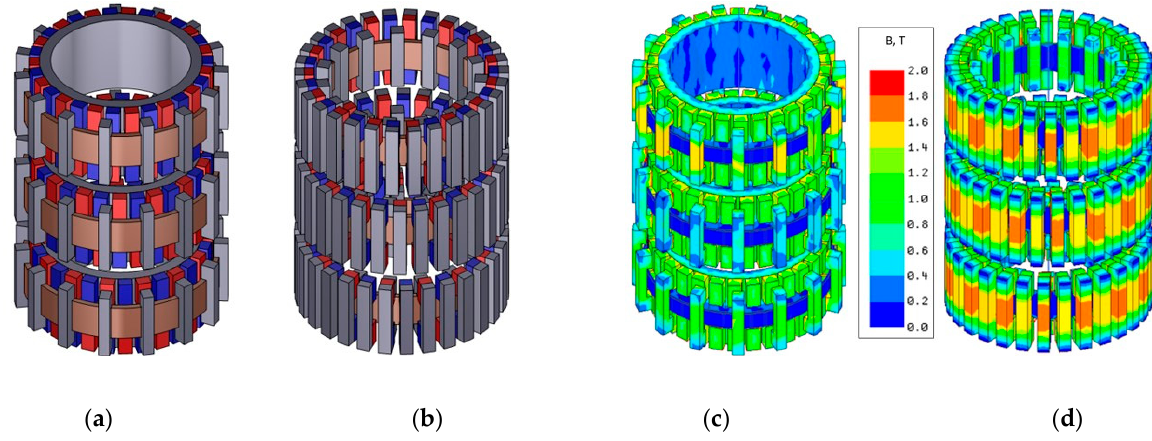
Figure 13. General view of the magnetic circuit of a three-phase TFMs: ( a ) with an internal rotor; ( b ) with an outer rotor. ( c ) Distribution of the flux density in the machines with an inner rotor and ( d ) an outer rotor.